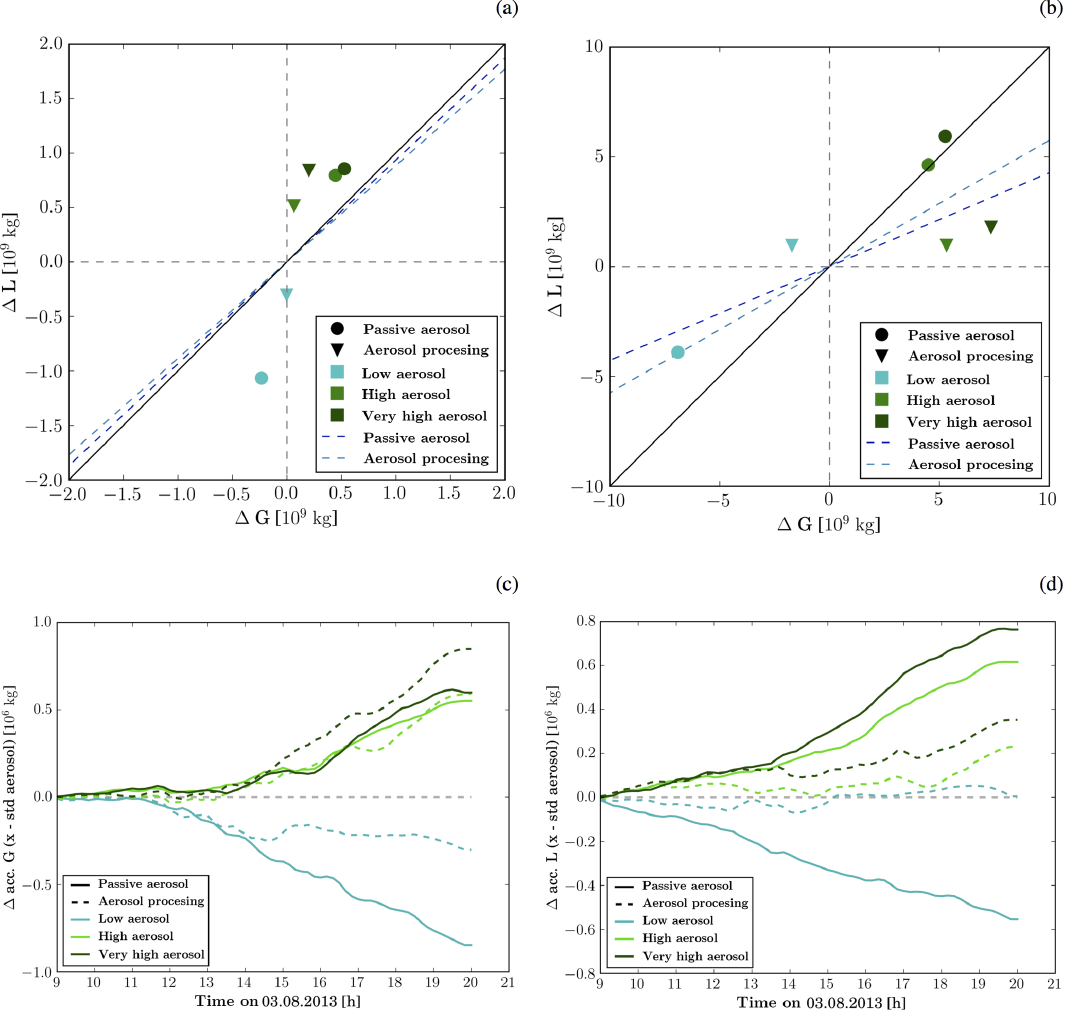
Figure 11. The panels in the upper row show (cid:49)G in relation to (cid:49)L for the time period between (a) 09:00–12:00UTC and (b) 12:00– 21:00UTC. The panels in the lower row show the difference in (c) accumulated condensate generation and (d) condensate loss relative to the simulation with standard-aerosol profile. Solid lines represent simulations with passive aerosols and dashed lines those with aerosol